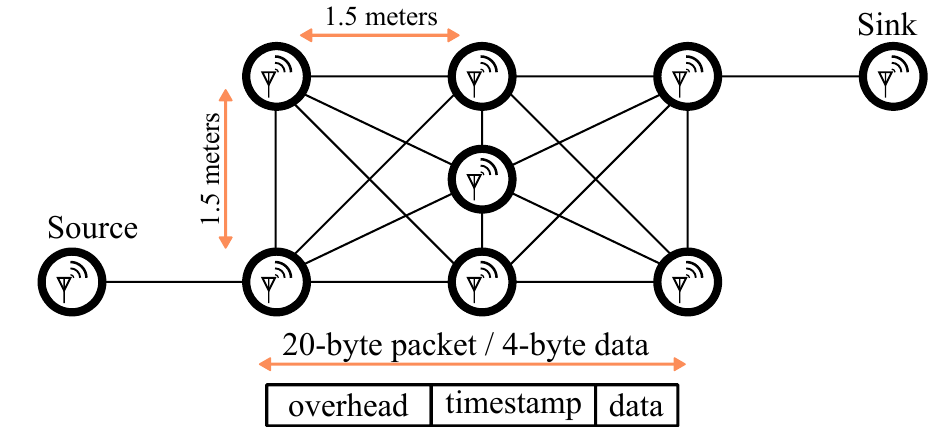
Figure 5. Power consumption benchmark of connection-oriented FruityMesh vs. flooding-based Trickle BLE nodes in a network routing scenario from